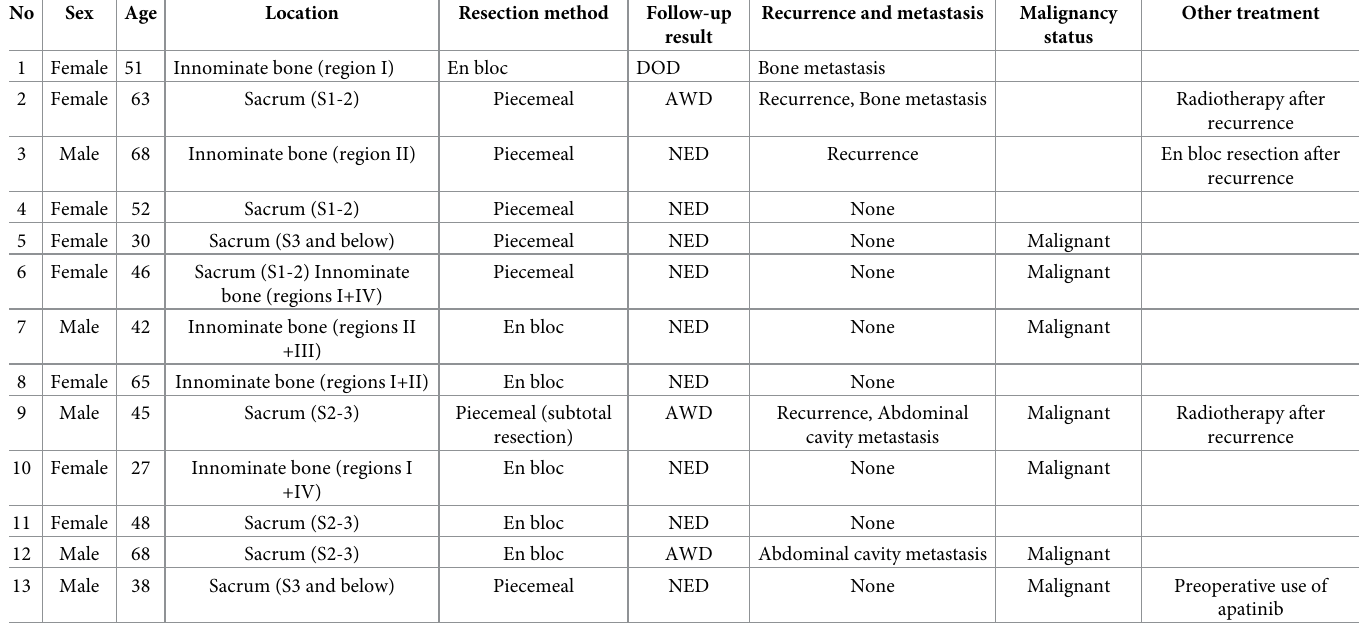
Table 1. Summary of the clinical data of 13 patients with primary solitary fibrous